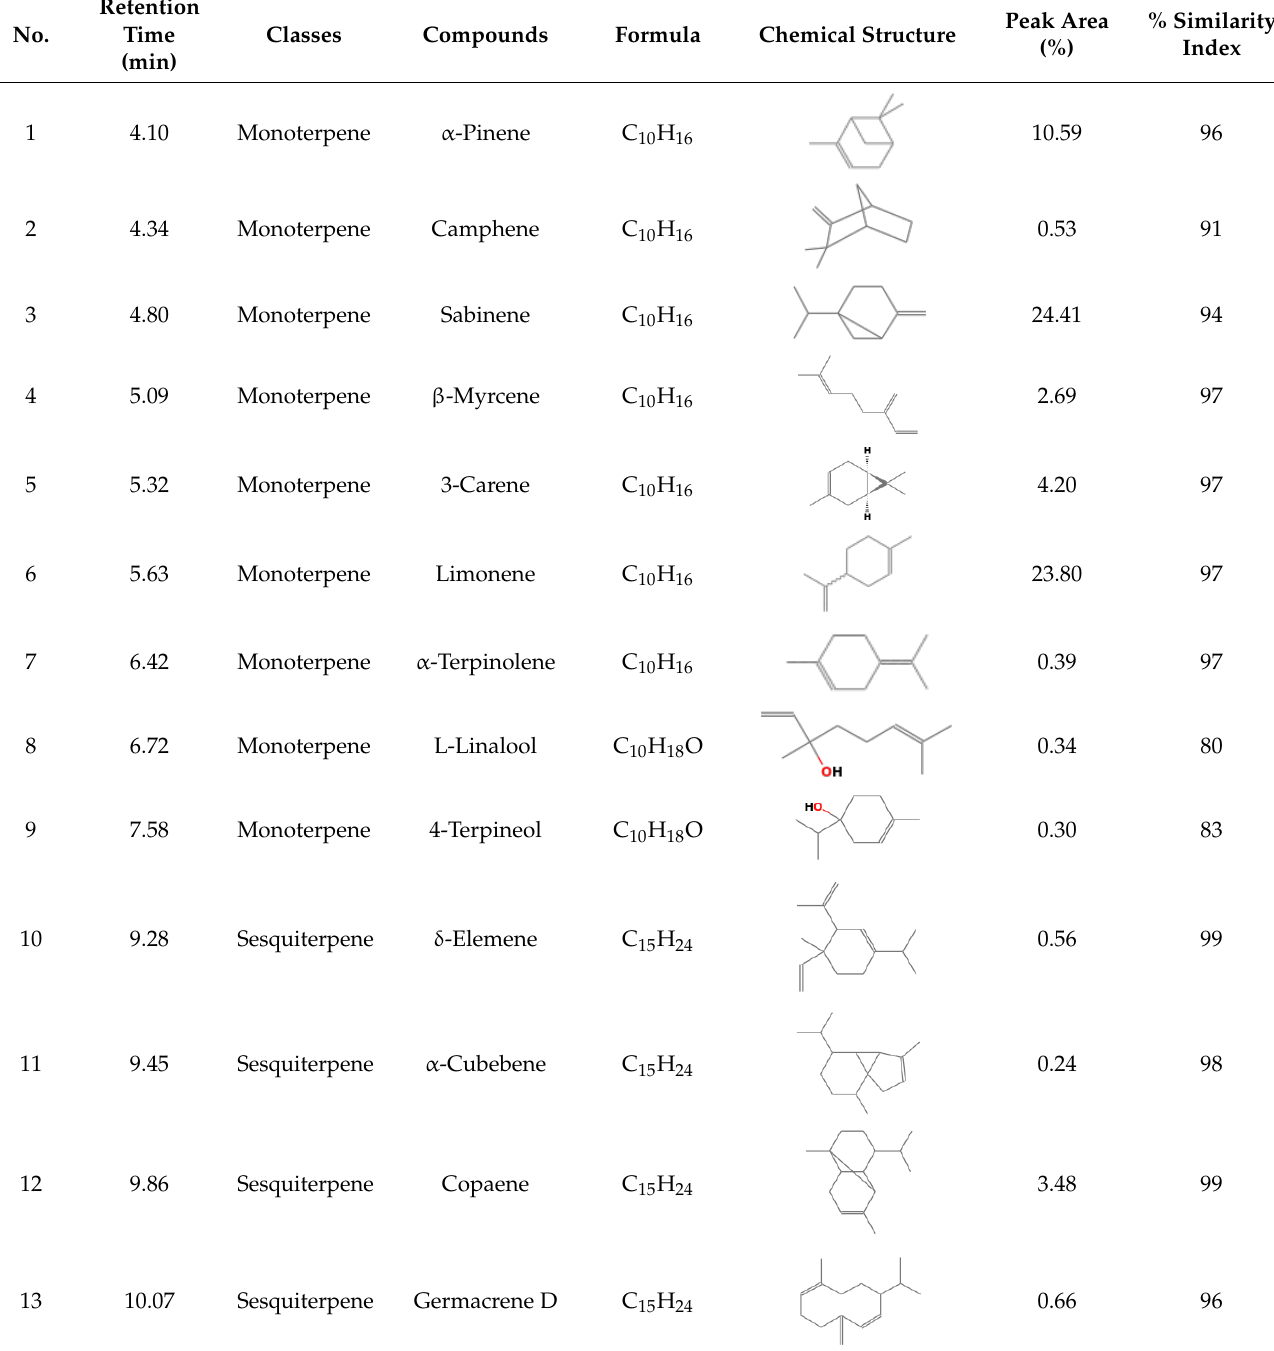
Table 1. Chemical composition of Piper nigrum L. essential oil.